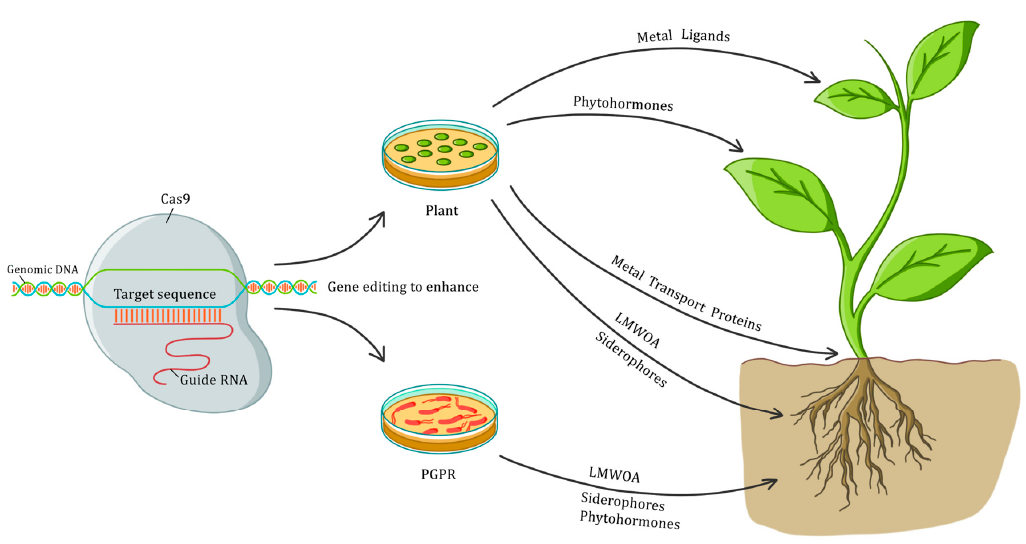
Figure 1. Potential advantages of CRISPR-Cas9 for phytoremediation. Gene editing of plants and plant growth-promoting rhizobacteria (PGPR) with the CRISPR-Cas9 system could increase the synthesis of a number of compounds that are critical to enhance the biomass yield, tolerance to contaminants, and the complexation, transport, accumulation and detoxification of